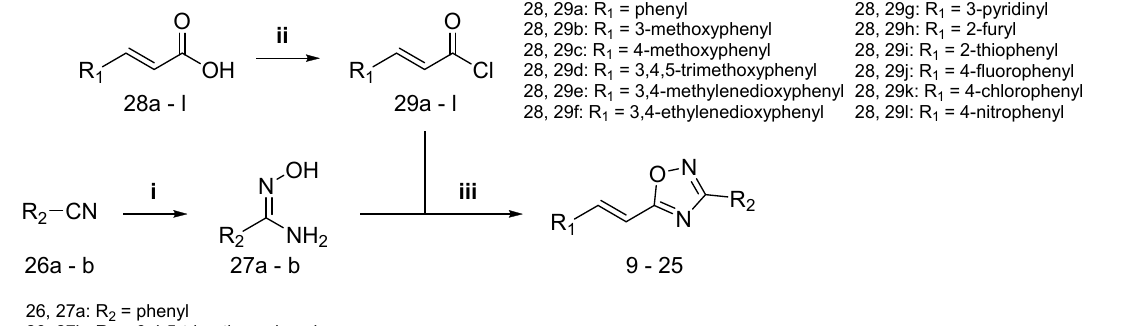
Table 1. Reaction times and yields for the synthesis of compounds 9–25. Compound Structure MW Time (min) a Yield